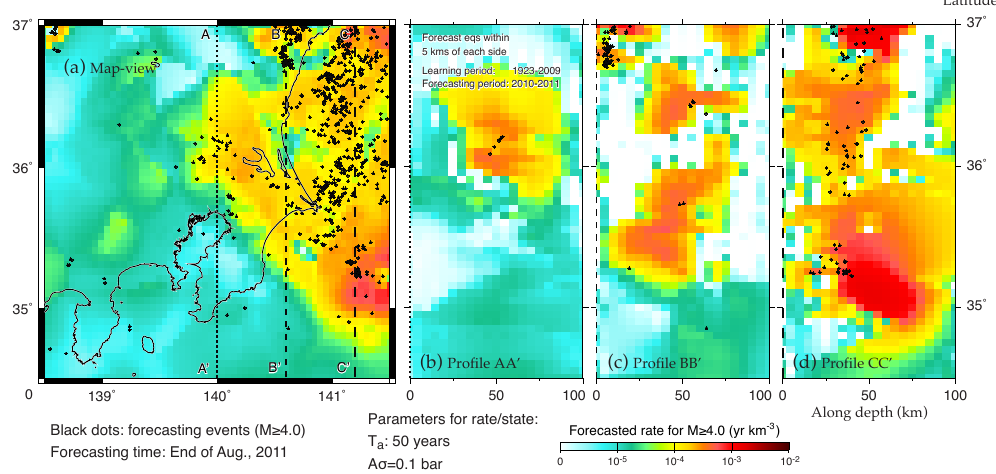
Figure 7. (a) Map view and (b) – (d) profiles of the three-dimensional forecasting models at the end of August 2011 and the distribution of the target earthquakes during 2010–2011. Black dots represent the M ≥ 4.0 earthquakes during January 2010 and August 2011. Earthquakes within 5km of each side of the profiles are presented.